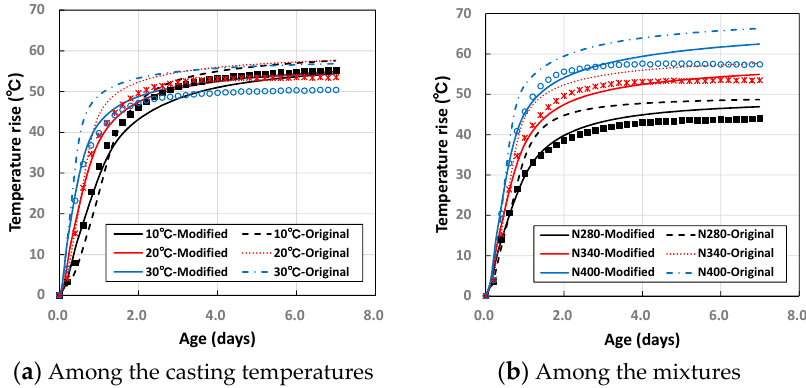
Table 3. Details of the mixtures and the experimental conditions in the adiabatic mass temperature rise tests [23].